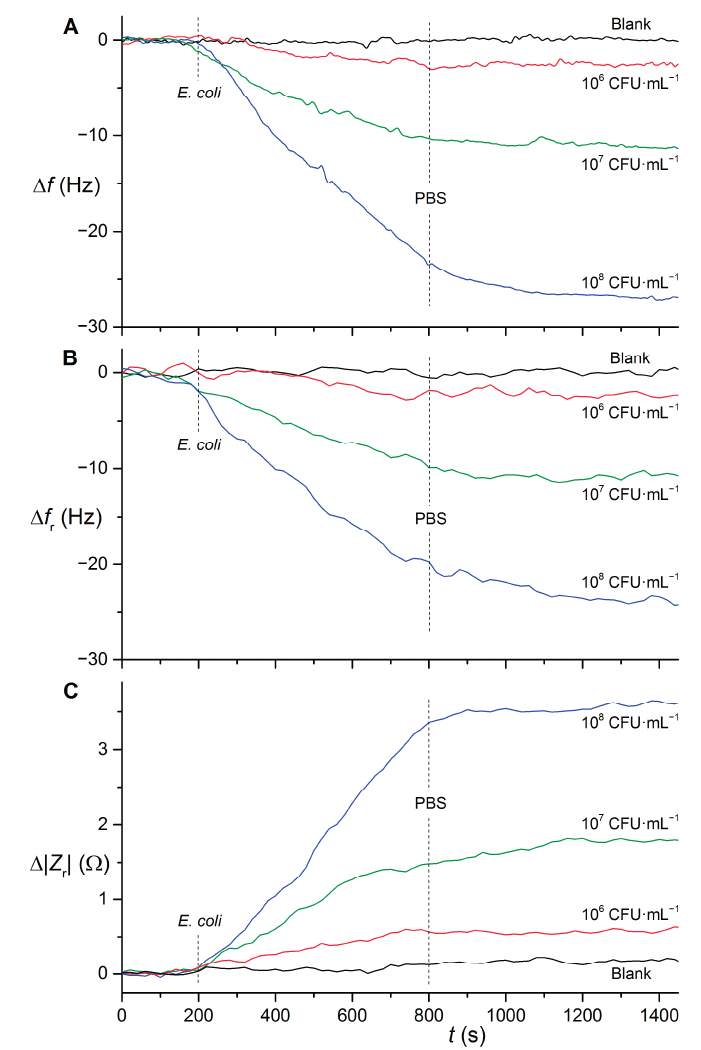
Figure 4. Binding interactions between E. coli DH5 α and antibody Abcam ab25823 immobilized directly using glutaraldehyde. ( A ) Frequency measured in active mode using the QCM Analyzer; ( B ) Frequency measured in passive mode using Agilent 4294A; ( C ) Amplitude of impedance at the resonant frequency measured in passive